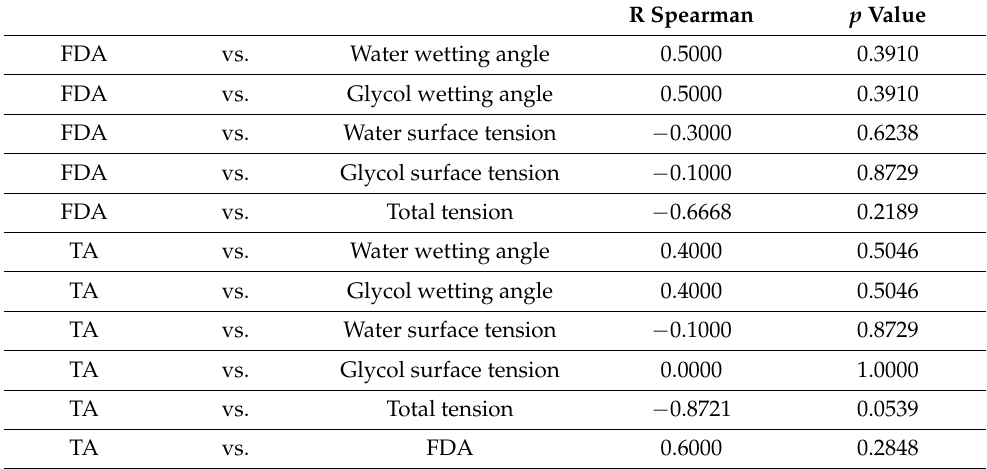
Table 2. Value of R (Spearman) coefficient between examined variables, FDA—fractal dimension analysis, and TA—texture